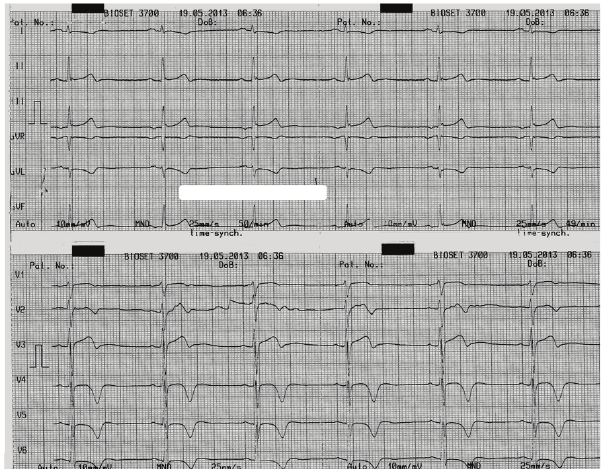
Figure 1: The electrocardiogram at the admission.